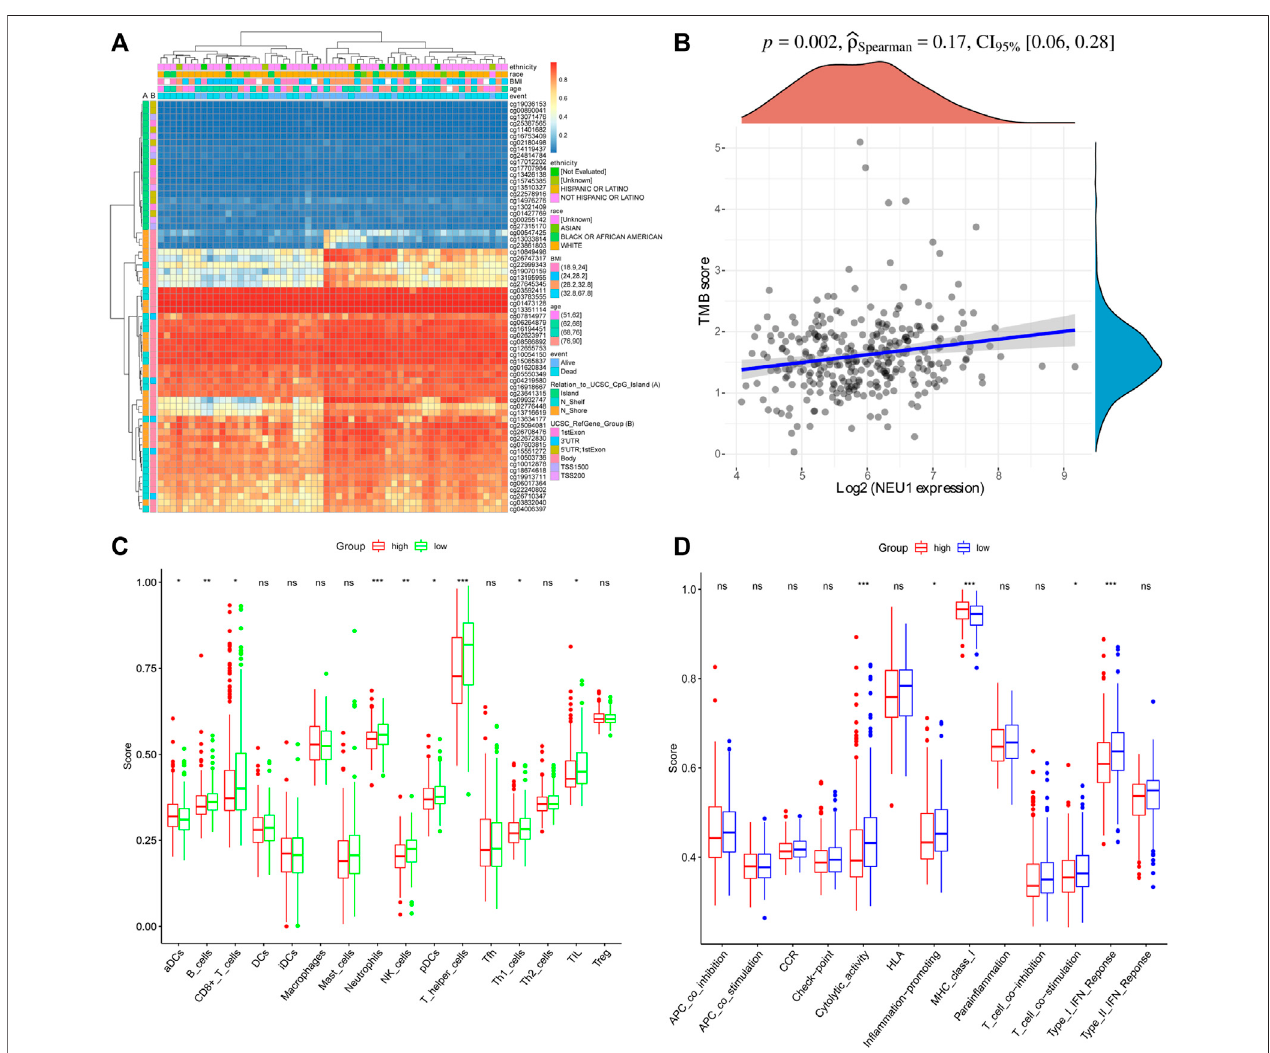
FIGURE 7 | DNA methylation of NEU1 and immune regulating roles of NEU1 (TCGA dataset) (A) The DNA methylation clustered expression of NEU1. Blue to red color representslowtohigh expression, and different colorside boxesdenoted ethnicity, race, age,Bodymassindex (BMI), event, UCSC RefGene Group, and Relation to UCSC CpG island (B) Correlation analysis of NEU1 expression and TMB score. The density curve on the right indicates the distribution trend of the TMB score; the upper density curve indicates thedistribution trendofthe gene (C) The scoresof16types ofimmunecellsbetweenhigh and lowNEU1 expression groups (D) The scores of 13 types immune-associated pathways between high and low NEU1 expression groups. ns represents p ≥ 0.05; * p < 0.05; ** p < 0.01; *** p < 0.001.